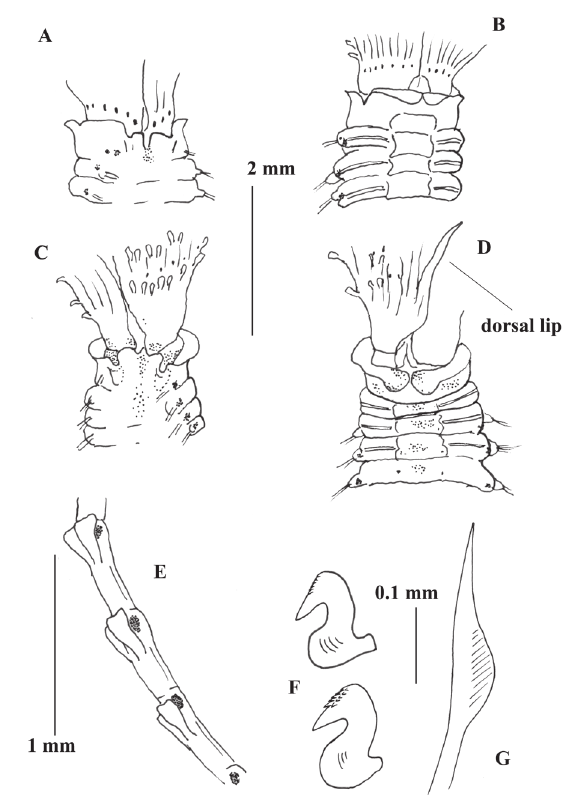
Fig . 1. – Branchiomma bombyx : A, C, anterior end, dorsal views; B, D, anterior end ventral views; E, detail of radiole, showing stylodes and radiolar eyes; F, thoracic uncini in different views; G, thoracic inferior